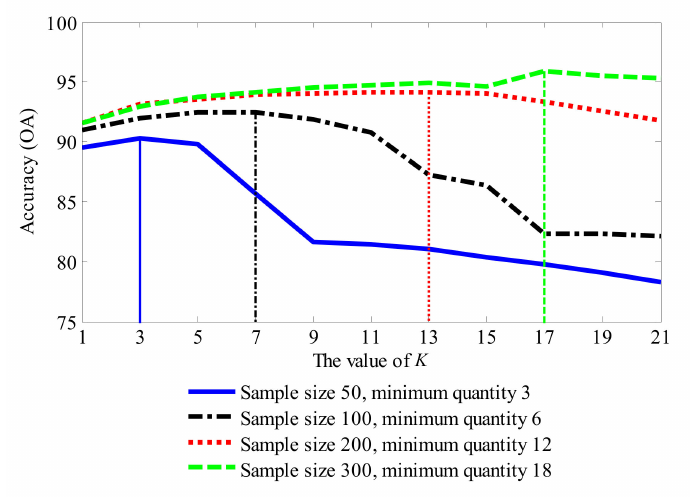
Figure 21. The K -OA curves with different sample scale.